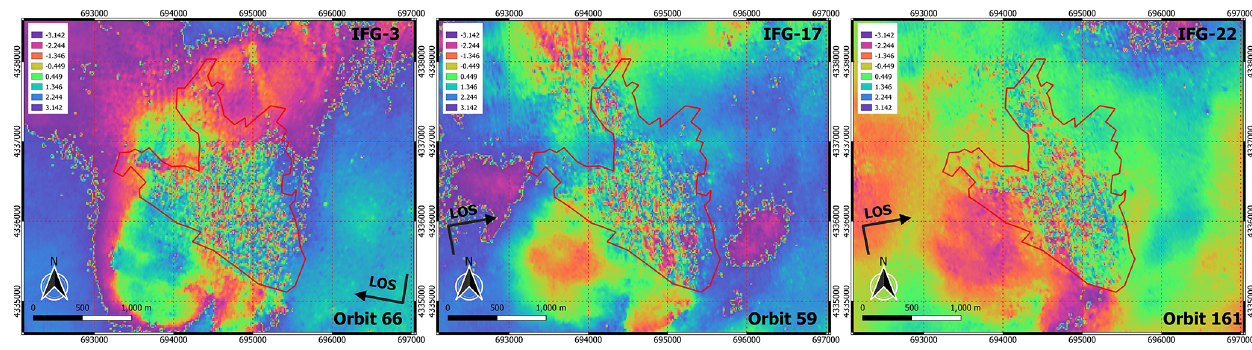
Figure 10. Kherba main event interferograms; biased pixels inside the red line correspond to incoherent changes. Table 4. Mean coherence change values inside the RoI. Orbit Pre-event Co-event Post-event Pre-event Post-event coherence coherence coherence change change mean mean mean